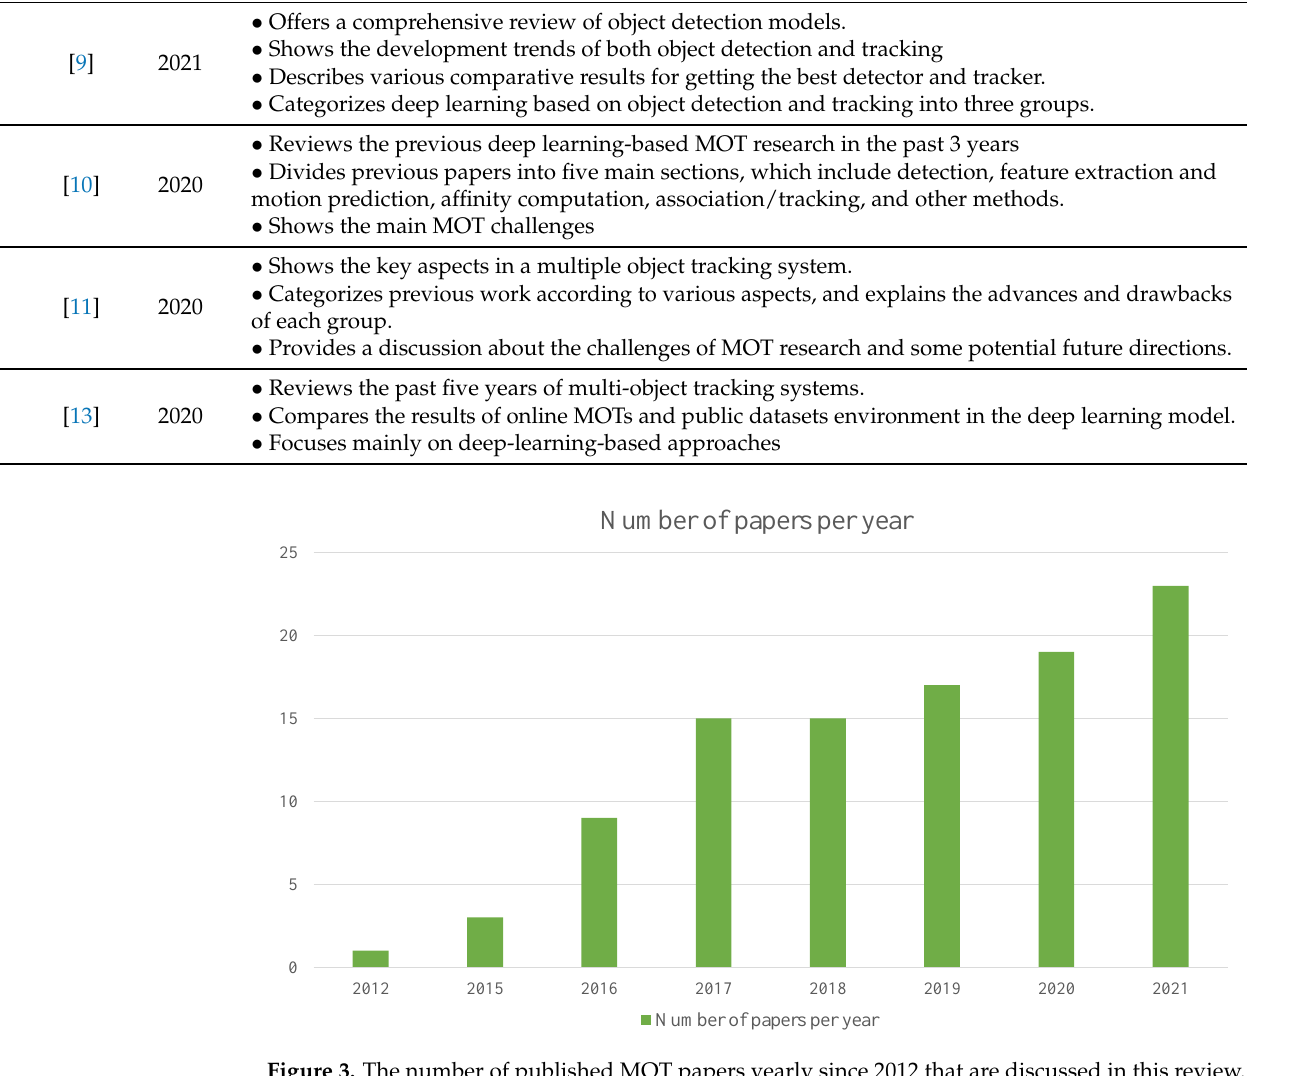
Figure 3. The number of published MOT papers yearly since 2012 that are discussed in this